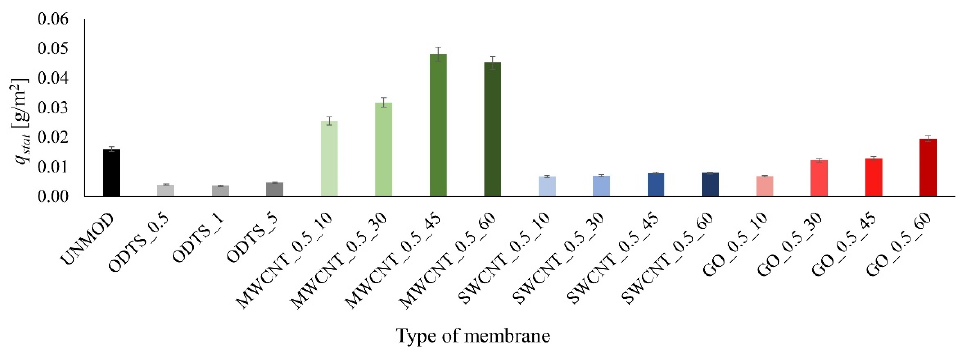
Figure 3. Mass of the adsorbed tetracycline in the stationary system.